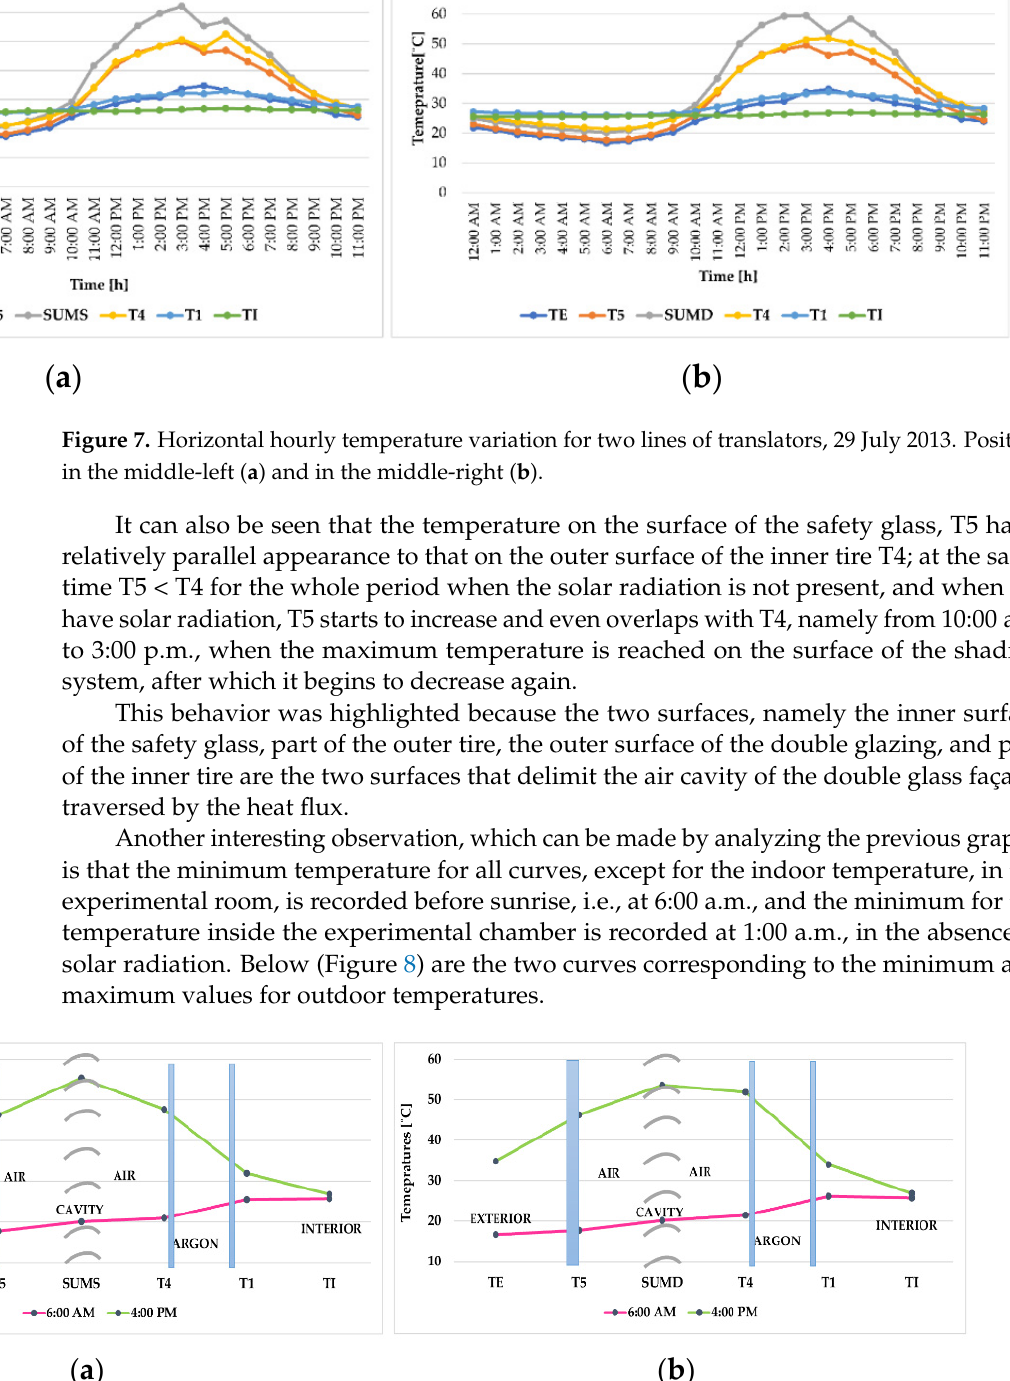
Figure 8. Horizontal temperature variation, when the outside temperature was minimum (6:00 a.m.) and maximum (4:00 p.m.), respectively, for 29 July 2013, for the left line of the translators ( a ) and for the right line of the translators ( b ).